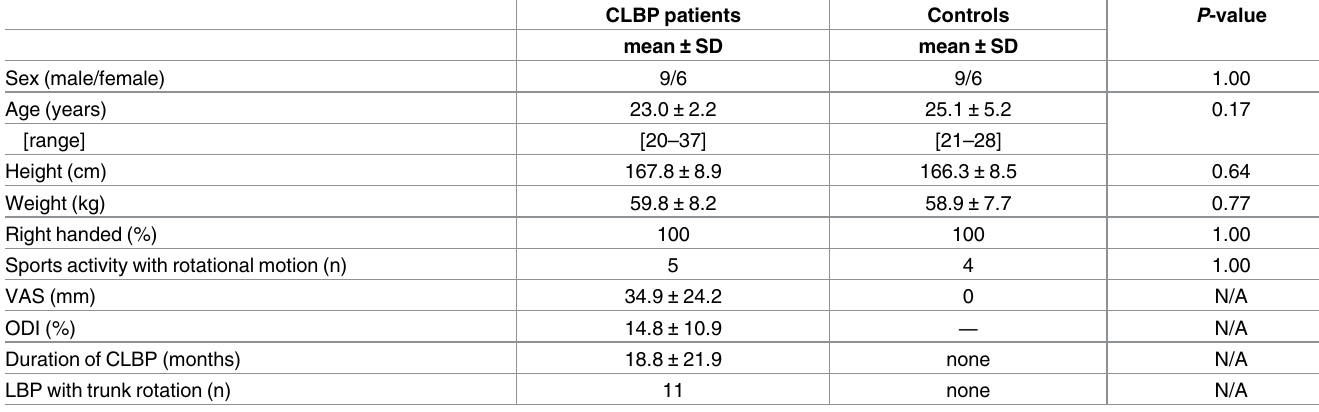
Table 1. Summaryof subject